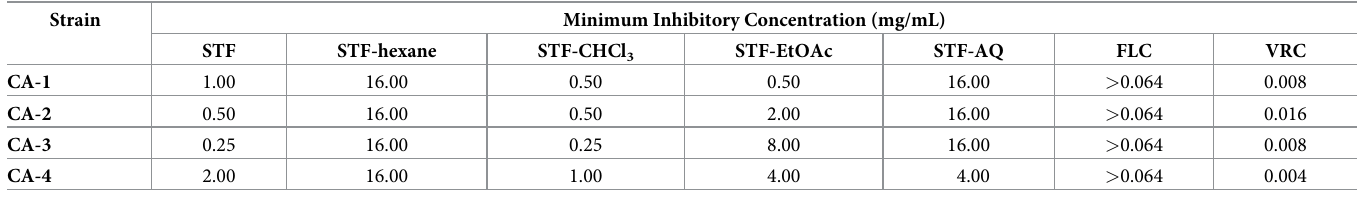
Table 1. Antifungal activity of S . torvum ethanol fruit extract and fractions against clinical isolates of C . albicans .